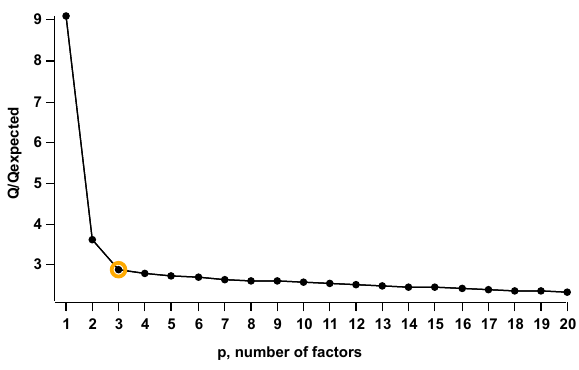
Fig. A3. Q/Q exp vs. p , number of factors. The solution chosen is highlighted by the yellow